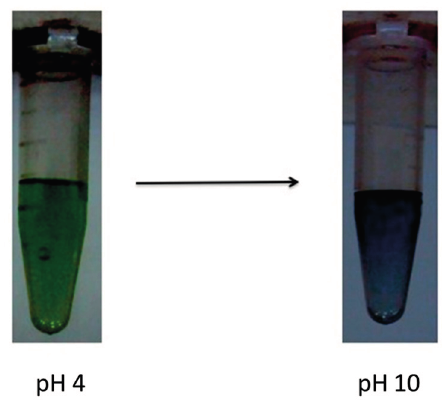
Figure 7. Color change of polymer with respect to pH; polymer exist in green color at pH 4 and 7 while it turns blue at pH 10.